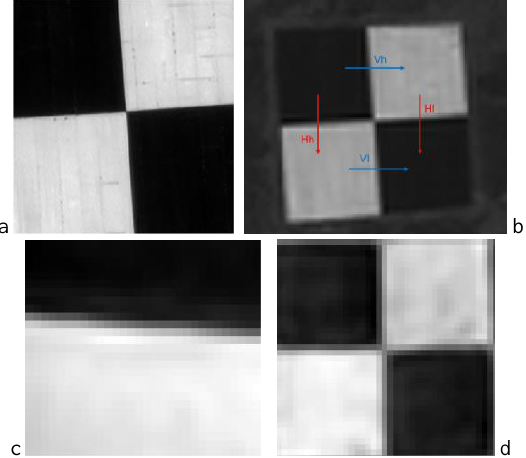
Figure 2. (a) Pan HD image part of the MTF target in Salon- de-Province, (b) the four directions (Hh, Hl, Vh, Vl) of the MTF calculation shown on the red band image, (c) building roof target in Munich (green band HD), (d) runway in Gibraltar airport (green band Figure 1. Location of the Ankara testfield (top), MAXAR image part (middle left), UAV orthophoto (middle right) and the topography of the study area obtained from the UAV (bottom).